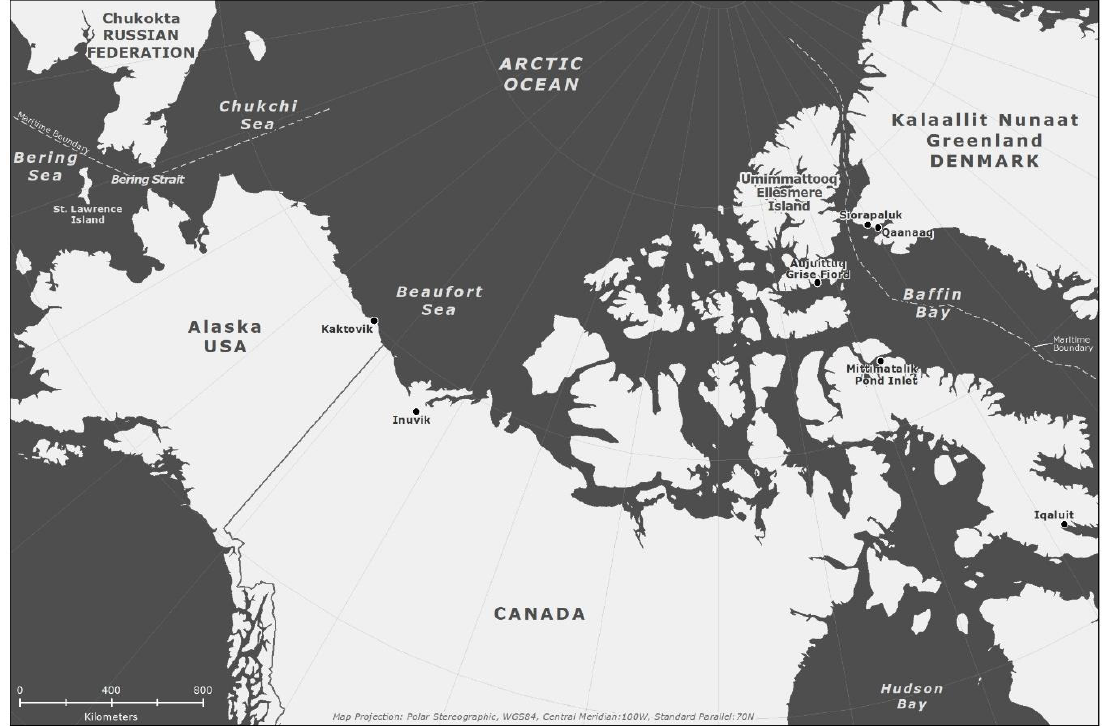
Figure 1. Map of the region and places mentioned in the text.